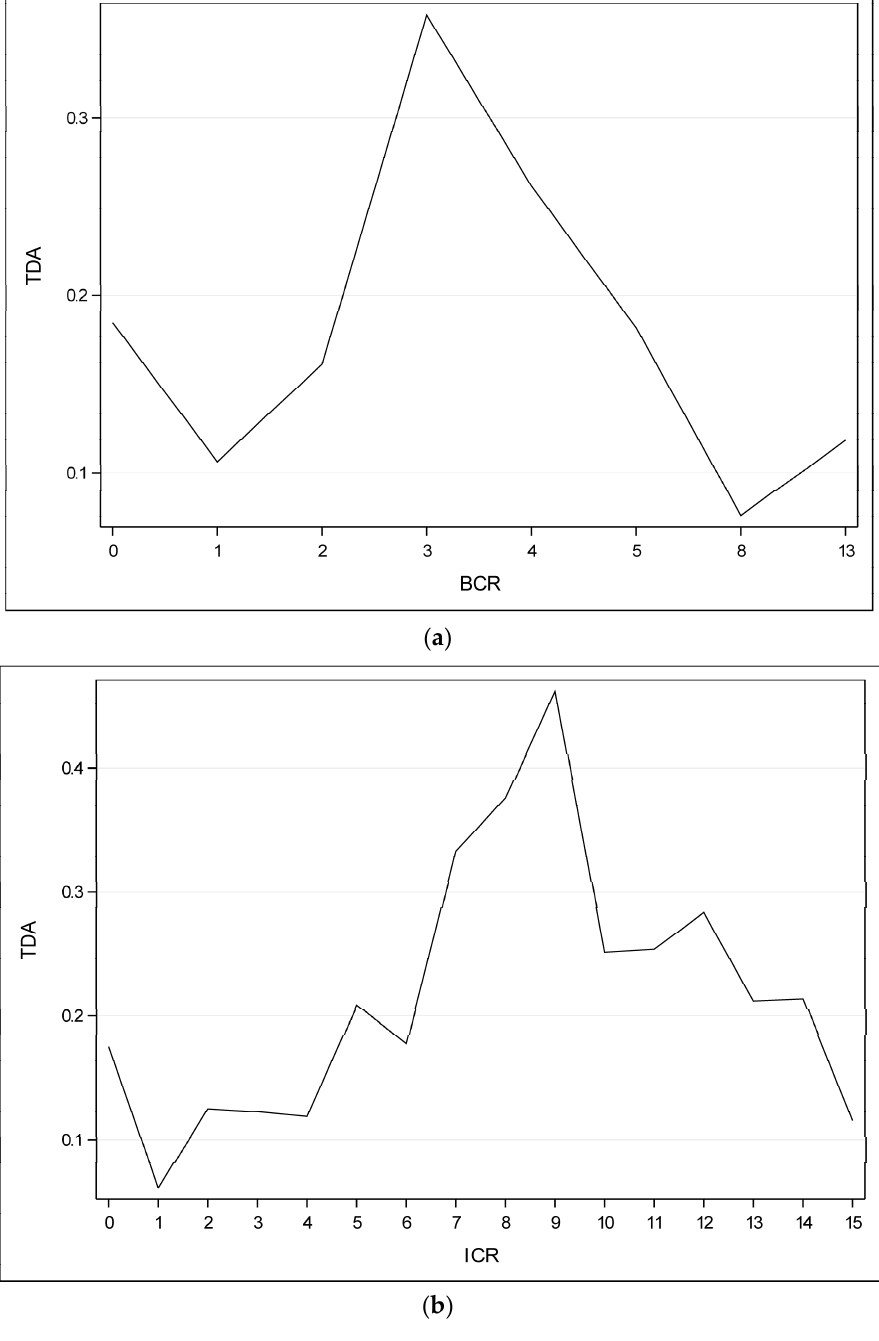
Figure 3. ( a ) BCR and Leverage ratio; ( b ) ICR and Leverage Ratio.